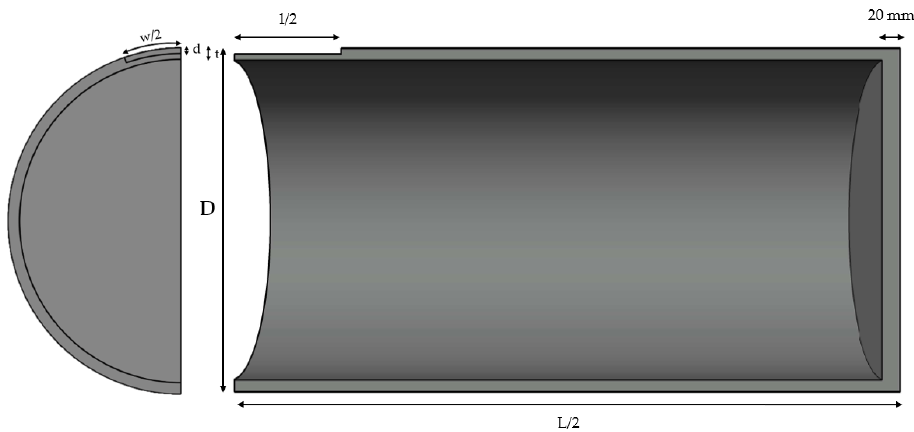
Figure 2. Dimension of the quarter-pipe model.